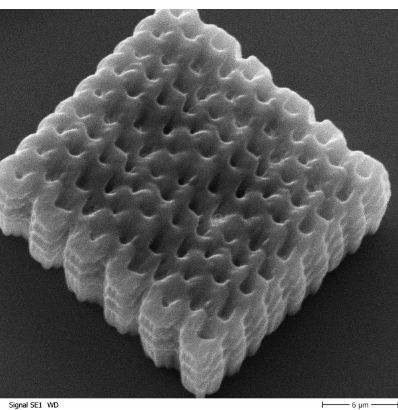
Figure 18. Dimension scale: nonlinear thrust struc- ture (4 microns element size)